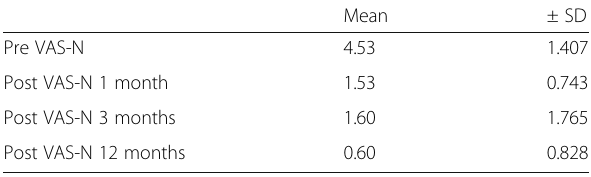
Table 7 Comparison between preoperative NDI and at different follow-up intervals among DCI